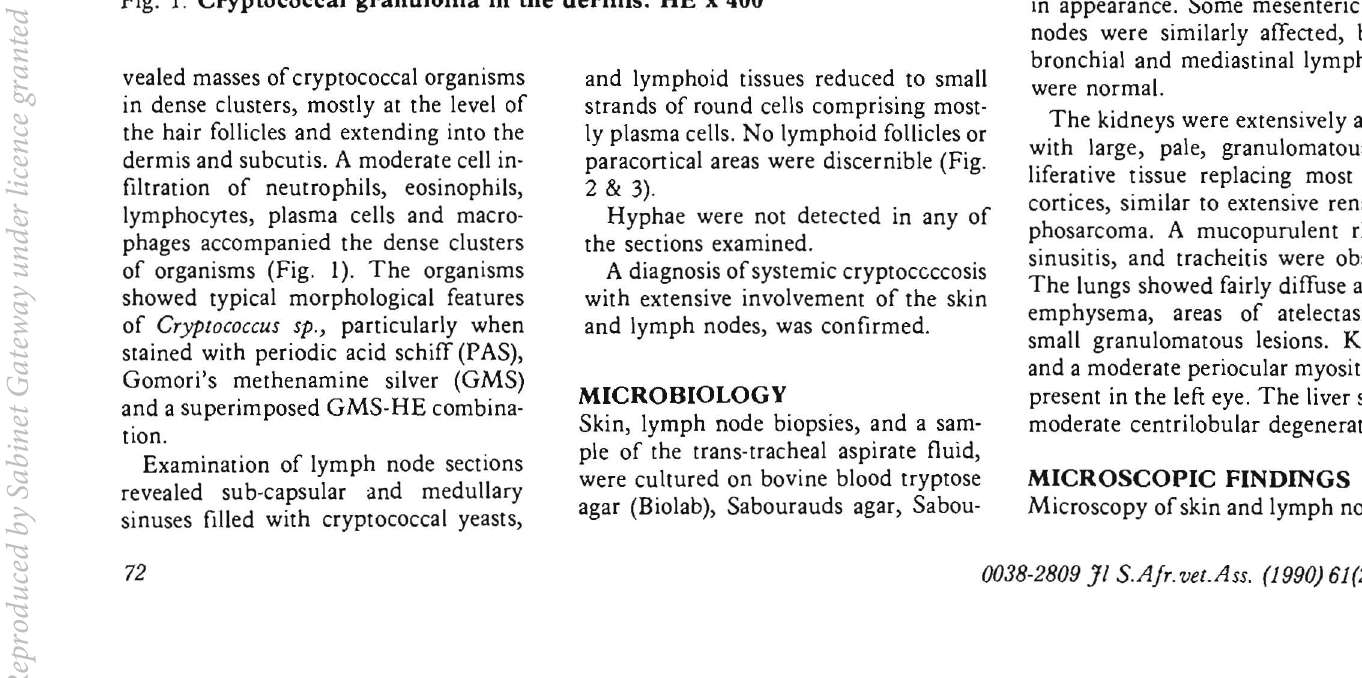
and lymphoid tissues reduced to small strands of round cells comprising most ly plasma cells. No lymphoid follicles or paracortical areas were discernible (Fig. 2 &